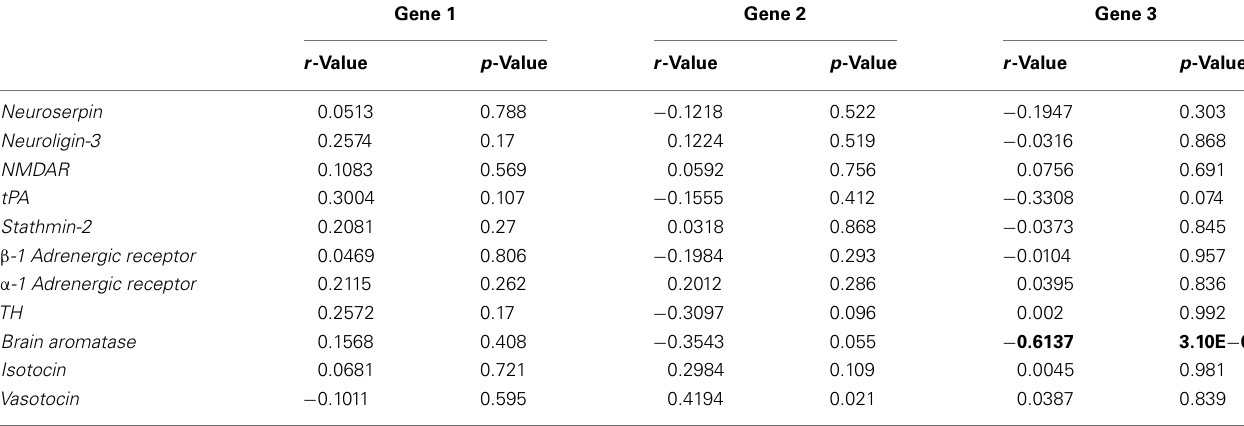
Table 2 | Input gene loadings onto multivariate axes.